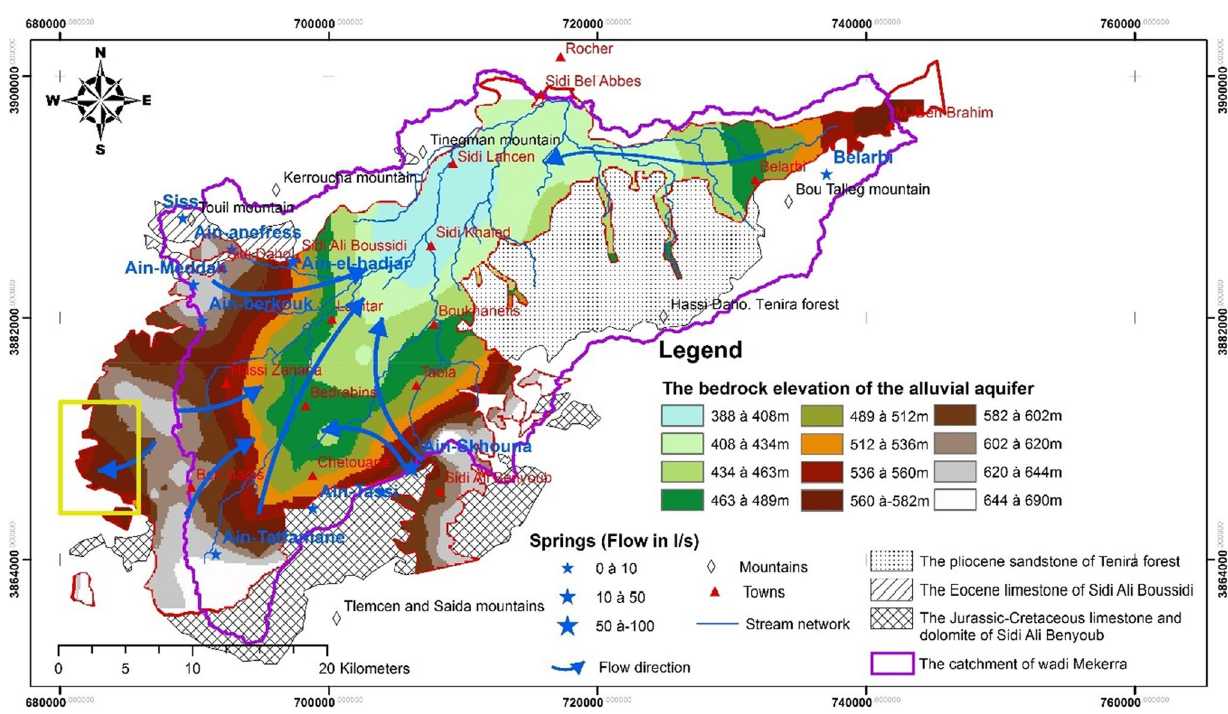
Fig. 12 Bedrock morphometry of the plio-quaternary alluvial